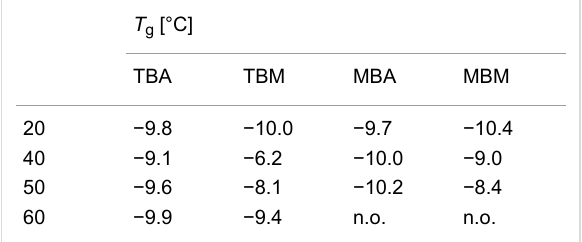
Table 2: T g values obtained from DSC measurements (second heating cycle). The T g of the pure IL [BmimSO 3 H][PTS] is − 11.9 °C. n.o. = not observed.